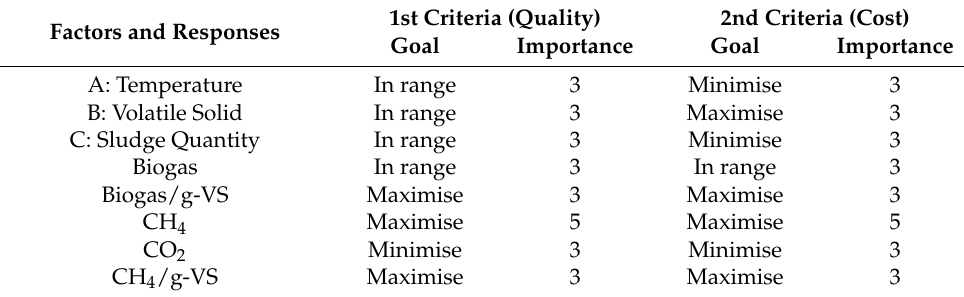
Table 14. The optimisation criterion.